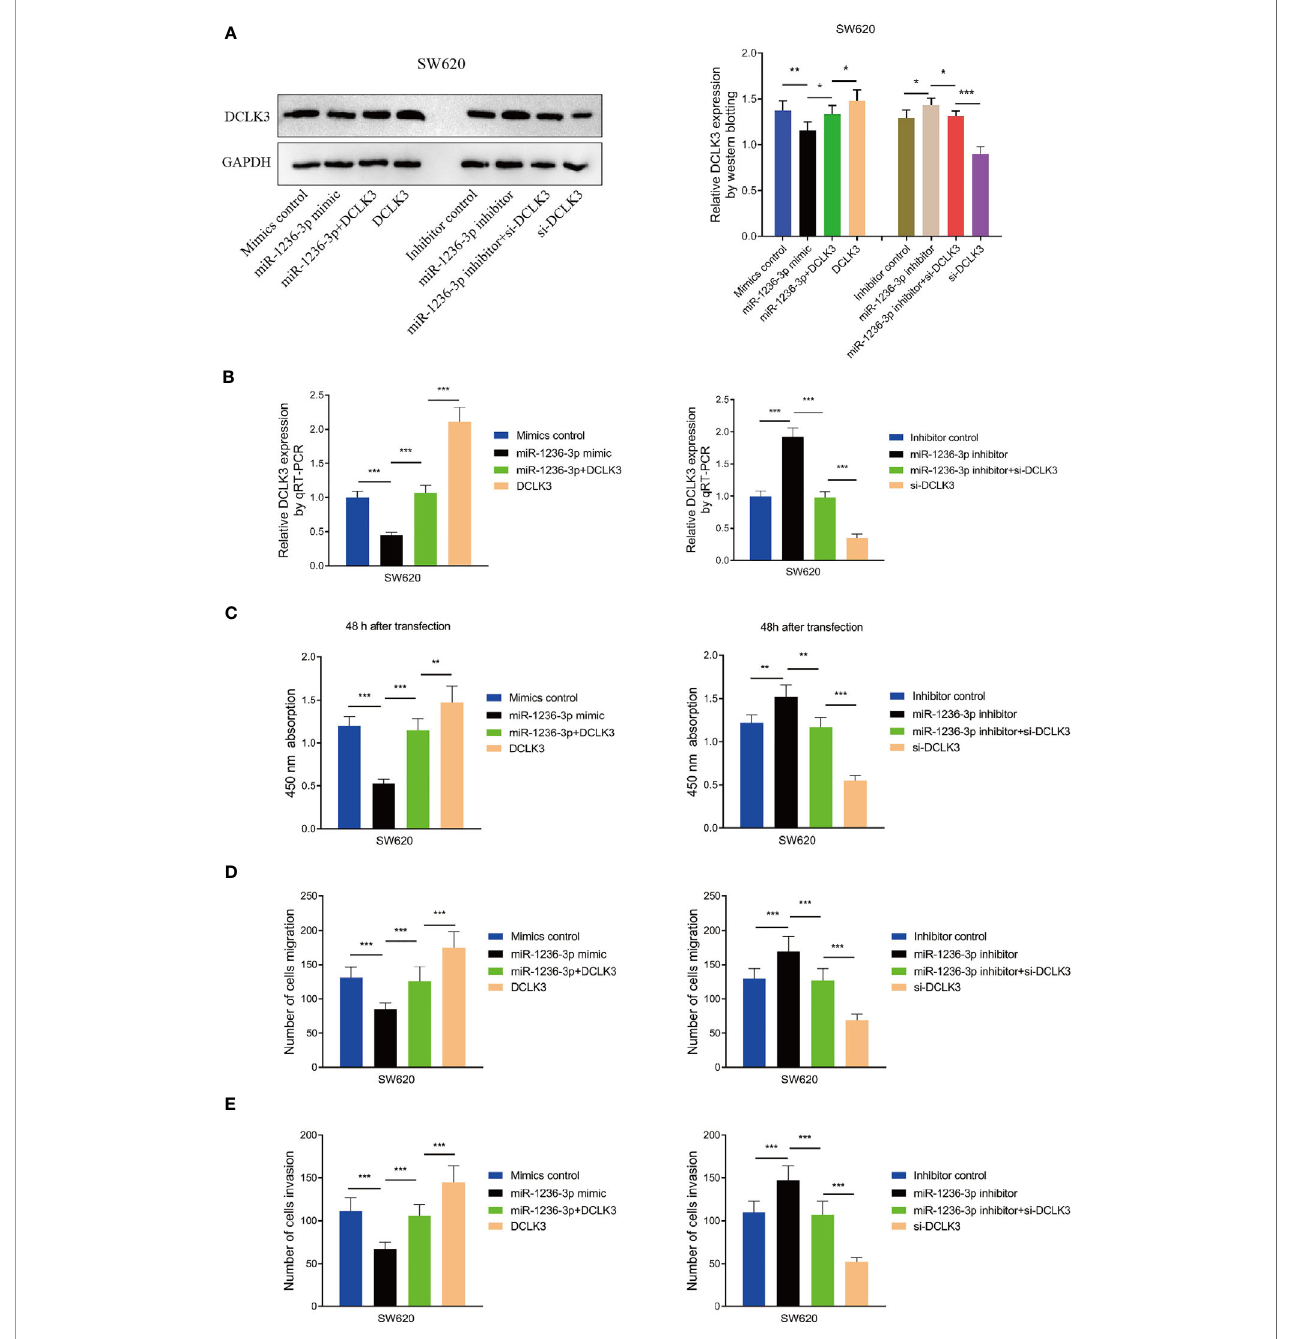
FIGURE 7 | DCLK3 mediated biological functions of miR-1236-3p in colon cancer cells. SW620 cells were co-transfected with miR-1236-3p mimic, mimic control, inhibitor, inhibitor control, overexpression (pcDNA3.1-DCLK3) and knockdown (si-DCLK3) of DCLK3. DCLK3 expressions were determined by western blotting (A) and qRT-PCR (B) . The CCK-8 at 450 nm (C) , transwell migration (D) , and invasion (E) assays were performed in SW620 cells. Error bars represent the mean ± s.e.m. *P < 0.05, **P < 0.01, ***P < 0.001 by Student ’ s t-test, six replicates per